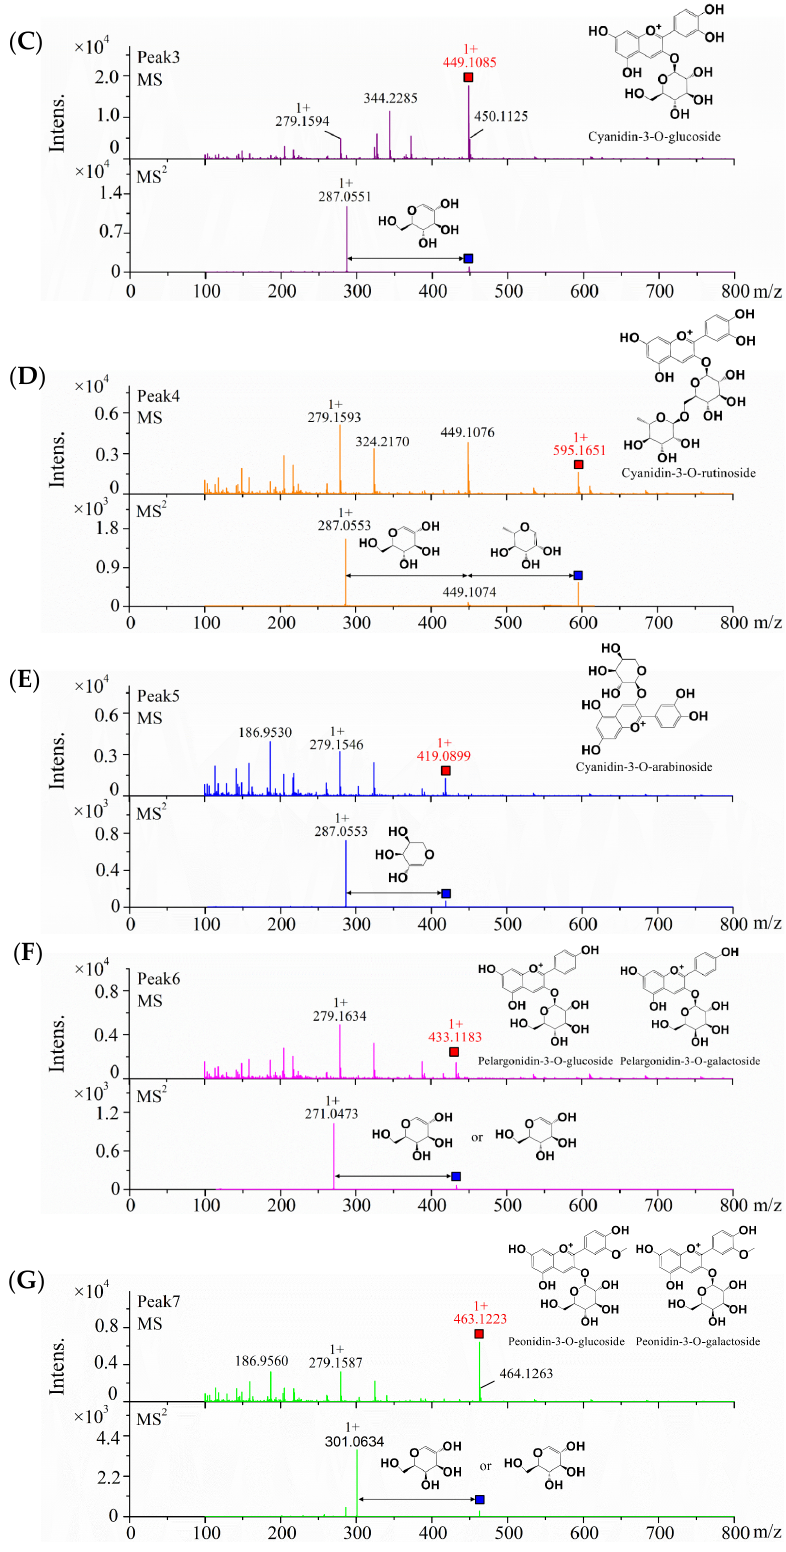
Figure 1. Identification and analysis of anthocyanins in five blueberry extracts. ( A ) HPLC chromatogram with UV detection at 280, 360, and 520 nm of S1 from Northeast China. ( B – G ) +MS and +MS2 of six different skeletons of anthocyanin compounds in five blueberry extracts under positive ion mode [M+] by HPLC-MS/MS spectra.